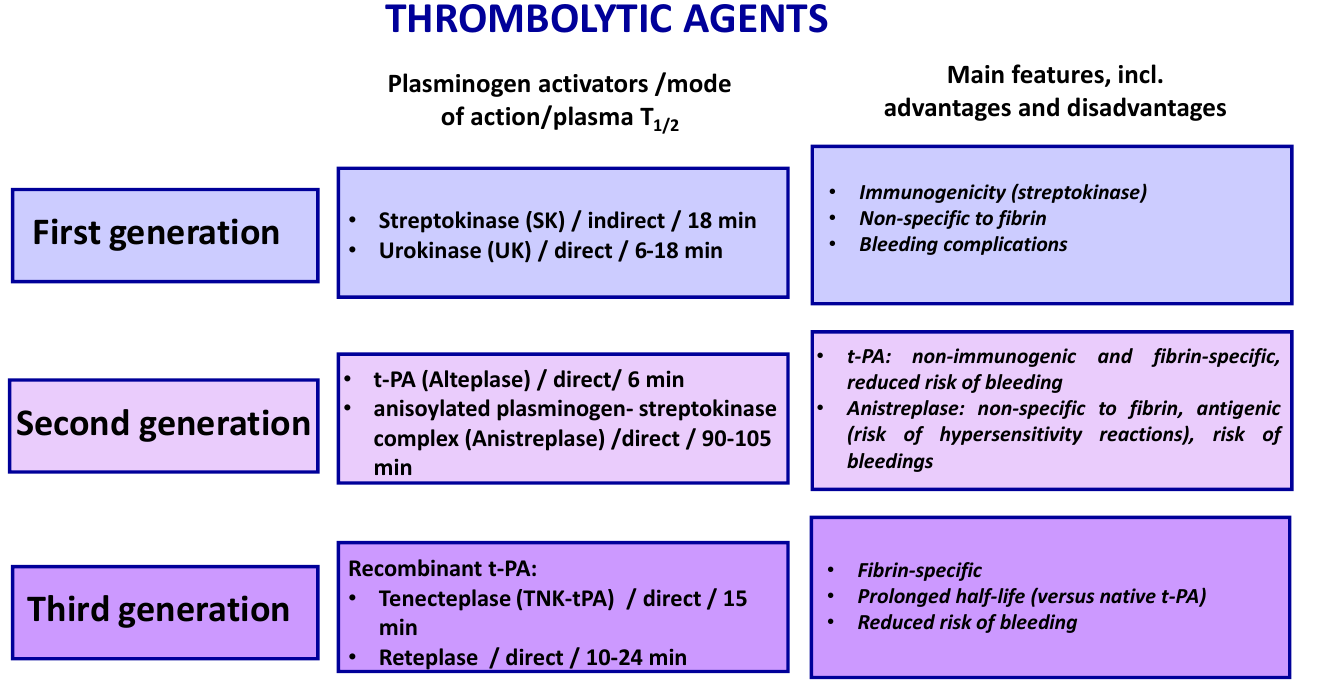
Figure 3. Different generations of thrombolytic drugs.